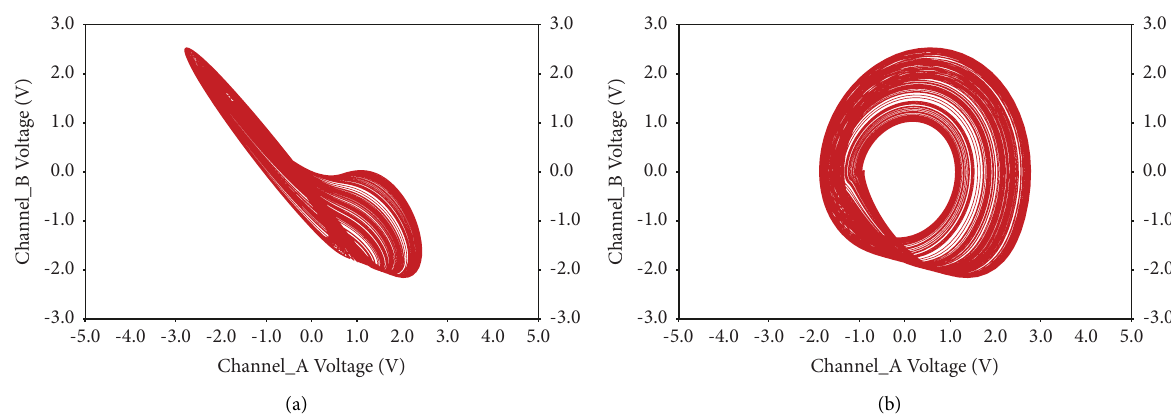
Figure 20: Chaotic phase diagrams of the system in analog oscillograph. (a) x